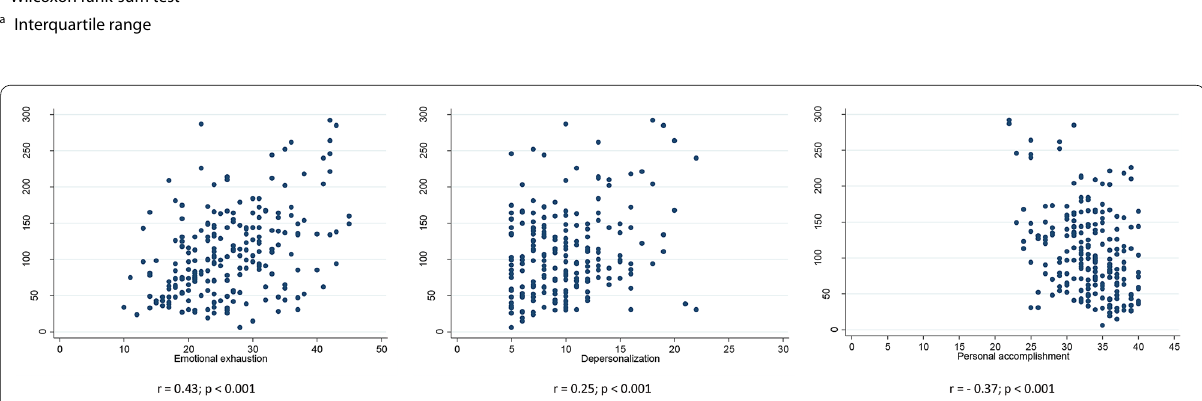
Fig. 1 Correlations between the Maslach Burnout Inventory domains and MDS-R scores ( n